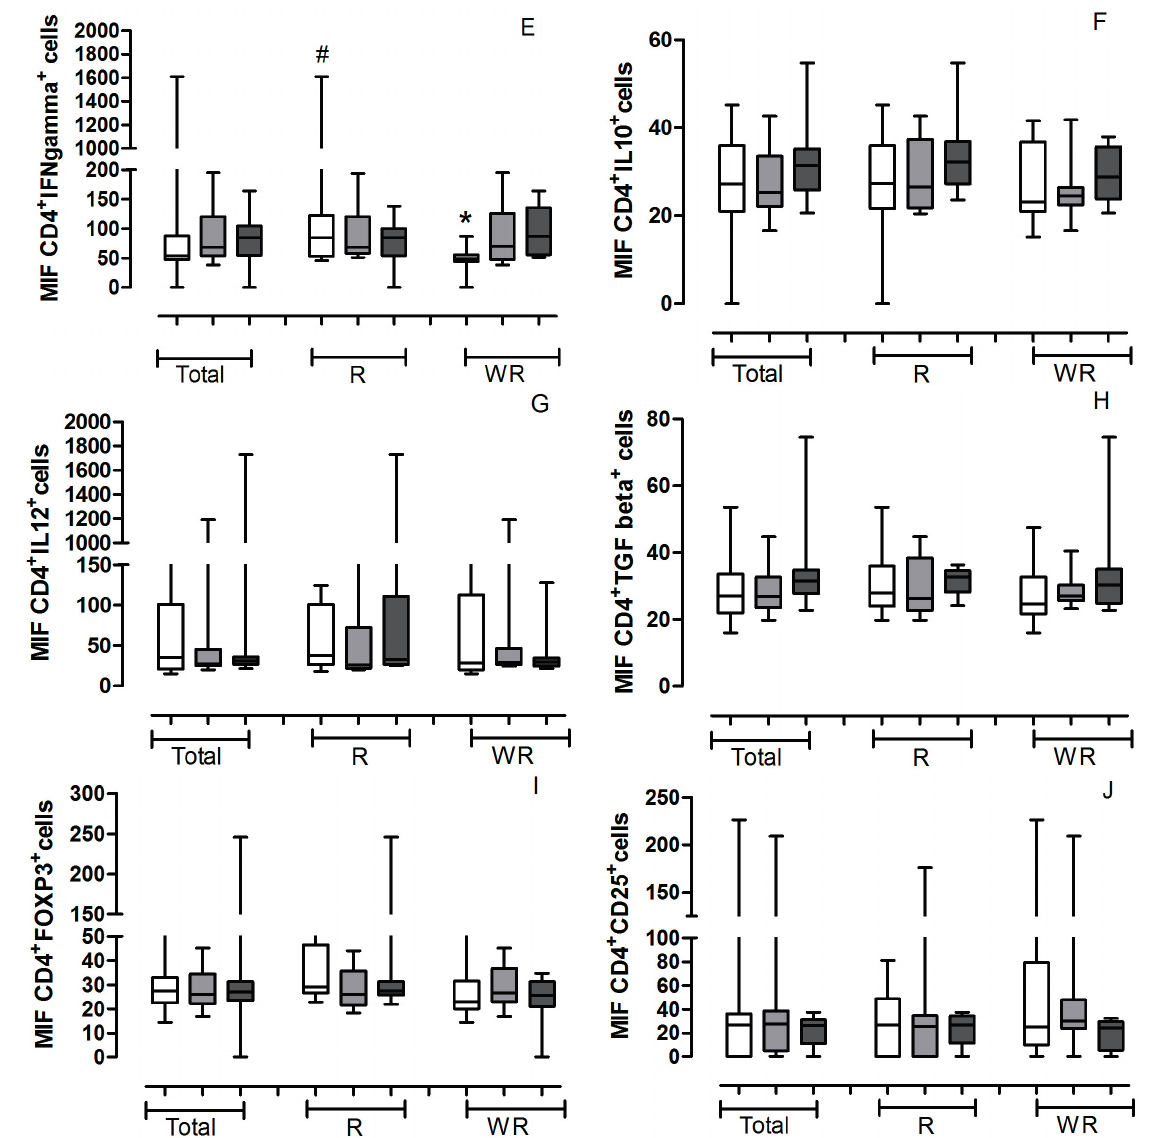
Figure 2. Values of median of intensity of fluorescence (MFI) of helper T lymphocytes positive for cytokines obtained from all the patients studied. The gate was determined for localization of cells corresponding to lymphocytes by for relative size (Forward Scatter, FSC) and granularity/complexity (Side Scatter SSC) in each experiment and for each patient. The helper lymphocytes marked with CD4 + and cytokines, receptor or transcription factor antibodies were analyzed in the pretreatment ( ) and in the 3th ( ) and 6th ( ) applications. The analyses were conducted with all patients studied (Total) and separately according to treatment outcome (Regression or Without Regression). All values are expressed in Median. ( A ) CD4 + IL-2 + ; ( B ) CD4 + IL-4 + * R3a vs . WR3a p = 0.0745; ( C ) CD4 + IL-17 + ; ( D ) CD4 + TNF- α + * Rpre vs . WRpre p = 0.0464; ( E ) CD4 + IFN- γ + # Rpre vs . WRpre p = 0.0927; * WRpre vs . WR6a p = 0.0042; ( F ) CD4 + IL-10 + ; ( G ) CD4 + IL-12 + ; ( H ) CD4 + TGF- β + ; ( I ) CD4 + FOXP3 + ; ( J ) CD4 + CD25 +